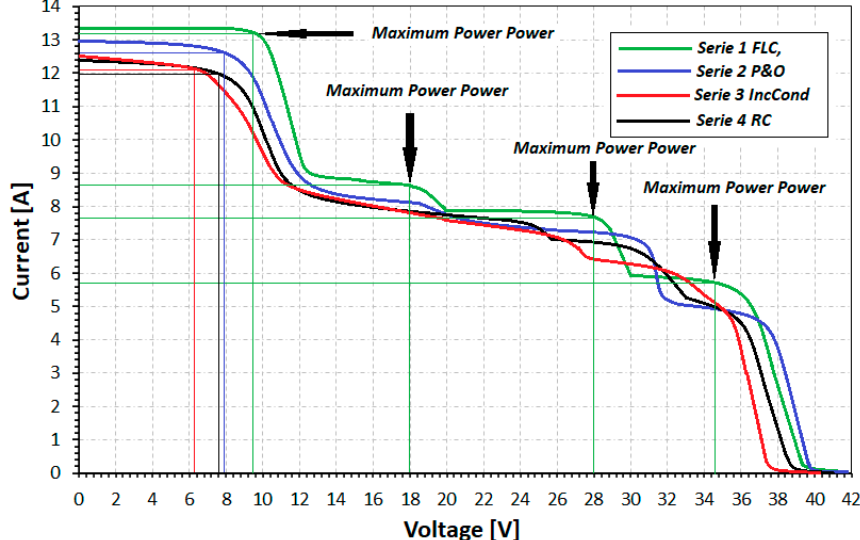
Figure 18. Comparison between MPPT techniques for 4 algorithms regarding the MPP determination for I-V characteristics of an industrial PV module.